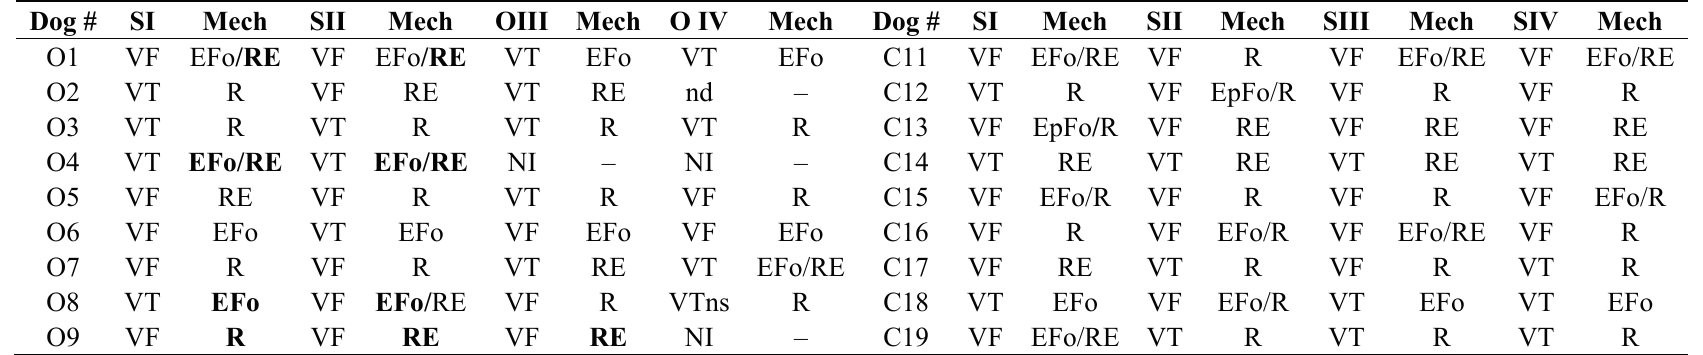
Table 3. Oxypurinol (OXY) group